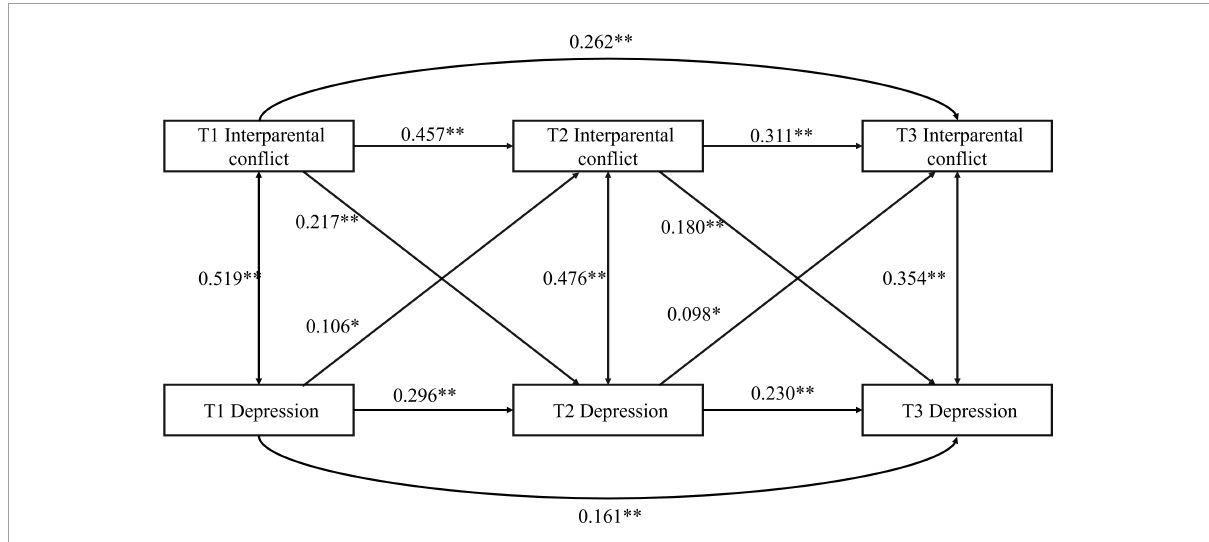
FIGURE1 Cross-lagged model of Chinese children’s perception of interparental conflict and depression. The cross-lagged model controls for sex; The single-lined arrow line is the prediction relationship, and the double-lined arrow line is the correlation relationship, the solid line is the significant path, and the dotted line is the non-significant path; All path coefficients are standardized. The same below. ∗ p < 0.05, ∗∗ p < 0.01.